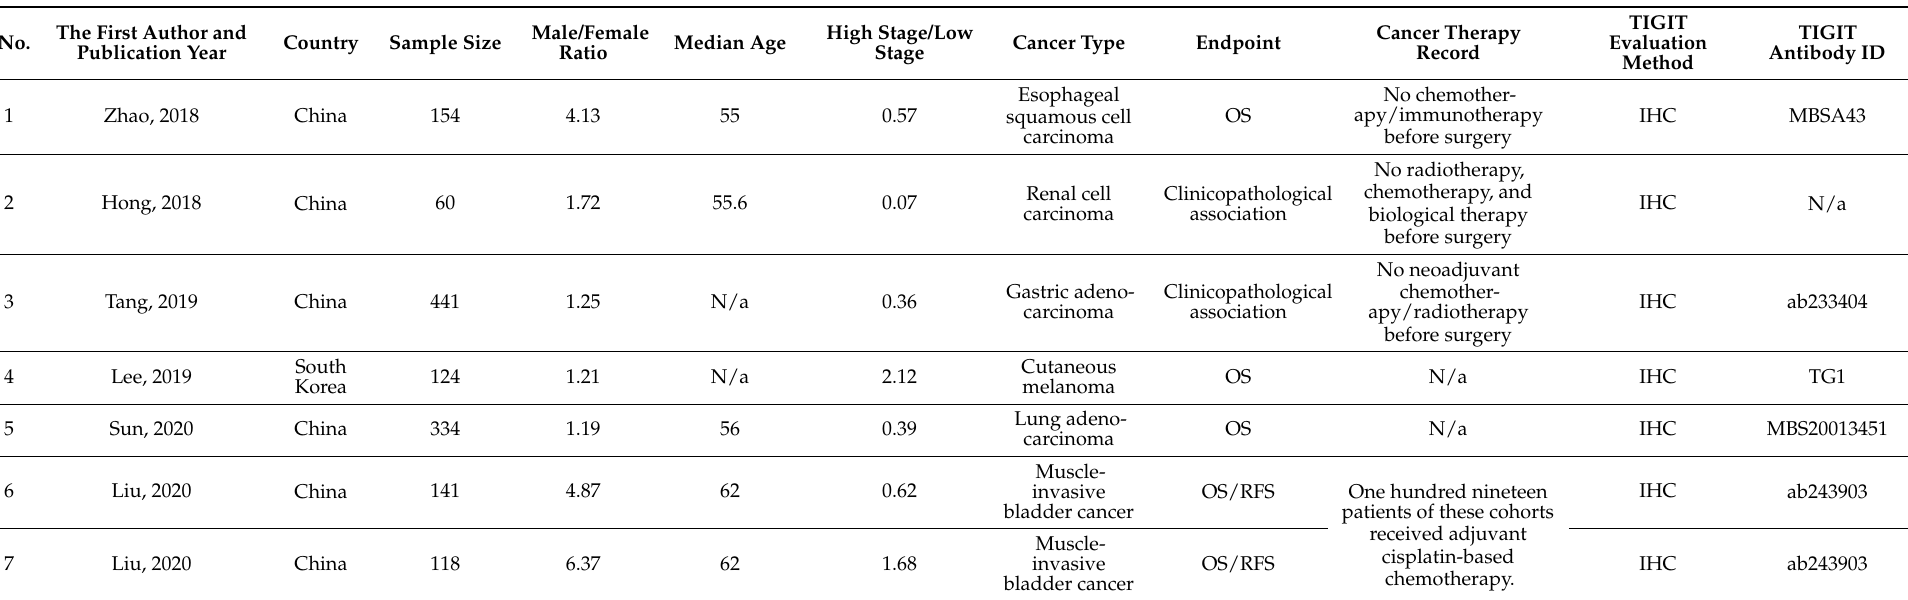
Table 1. The characteristics of included